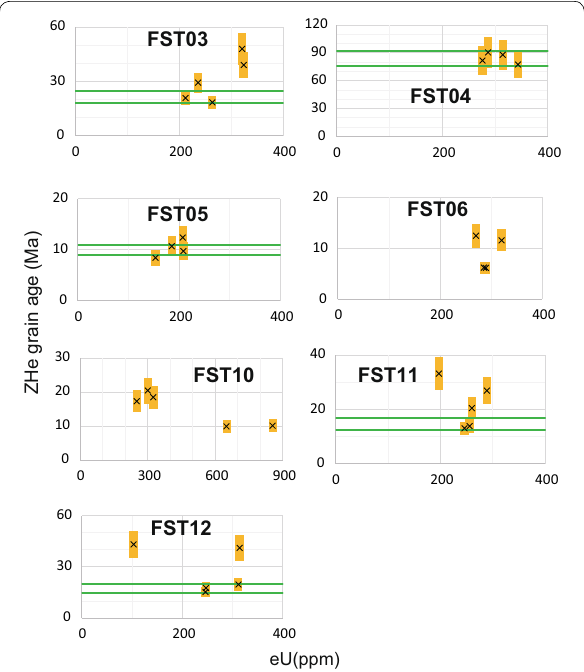
Fig. 3 Effective uranium (eU) ppm versus ZHe grain ages. Every grain range of age indicates 3σ range. Two horizontal green lines ± show the upper and lower limits of the weighted mean age, namely 95% and 95% confidence intervals. No green lines imply that the + − weighted mean age is unadopted because of poor